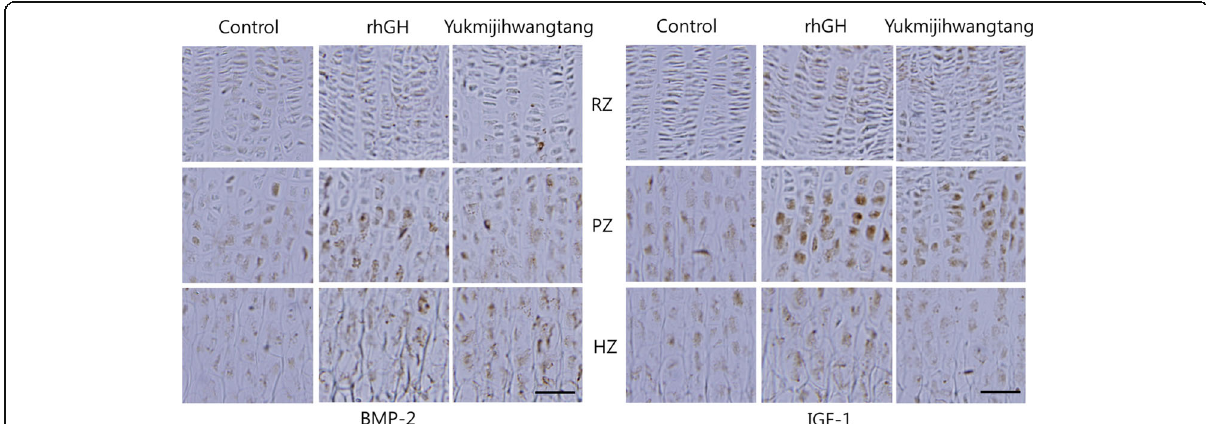
Fig. 6 Immunohistochemical localization of bone morphogenetic protein (BMP)-2 and insulin-like growth factor (IGF)-1 in the growth plate. The control group received distilled water, the rhGH group received 20 μ g/kg rhGH and the YJT group received 300 mg/kg YJT. RZ, resting zone; PZ, proliferative zone; HZ, hypertrophic zone. Scale bar = 400 μ